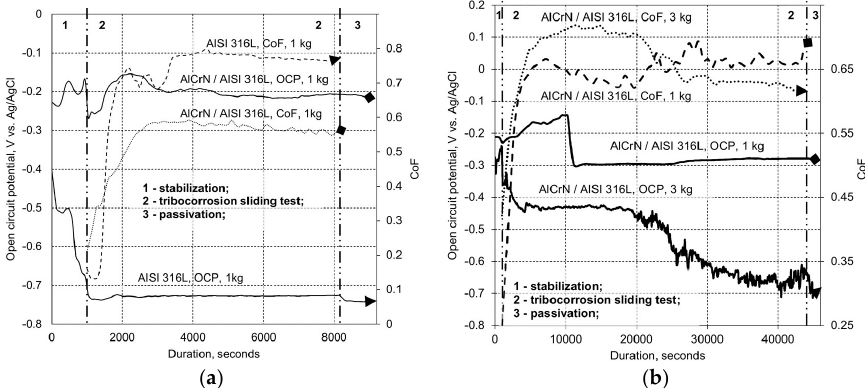
Figure 4. Chronopotentiometry results to show comparison in evolution of CoF and open circuit potential (vs. Ag/AgCl) of uncoated and the AlCrN PVD coated AISI 316L samples during short (2 h) ( a ); and extended (12 h) tribo-corrosion test of coated AISI 316L sample ( b ).